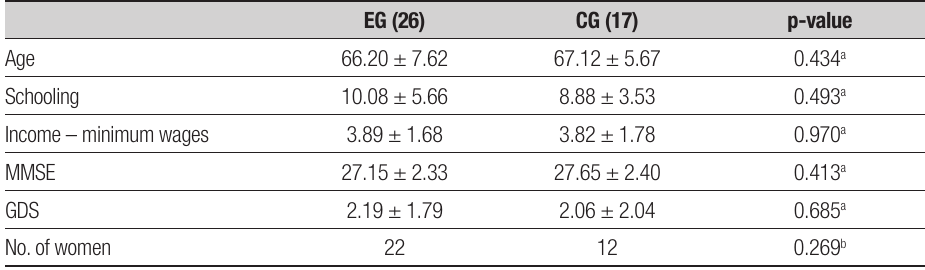
Table 1. Sociodemographic features of study sample.